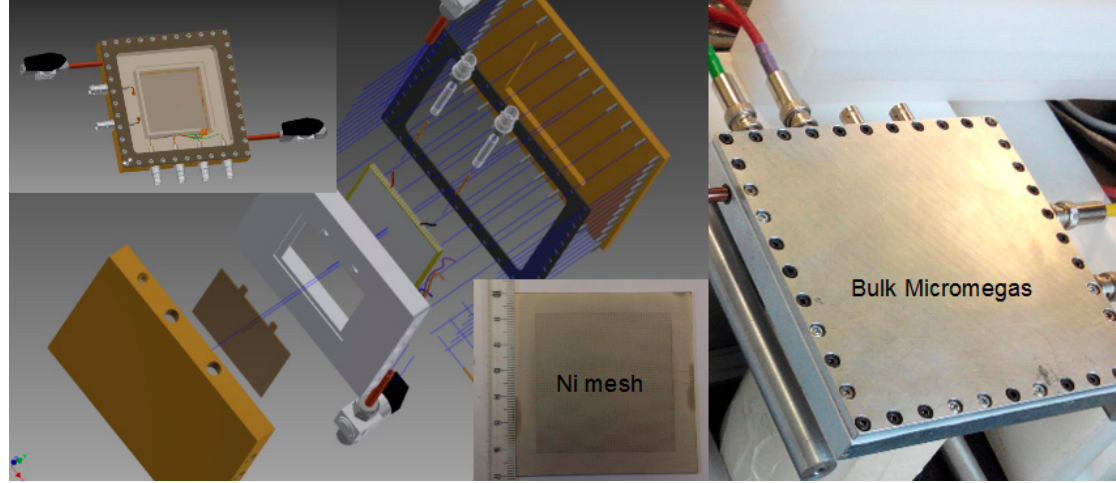
Figure 3. Design of the prototype detector unit and the experimental set-up at CEA/Irfu